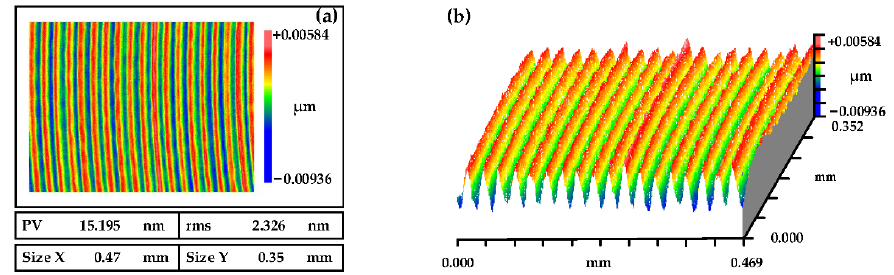
Figure 10. The roughness of the SPDT process. ( a ) Measurement Results, and ( b ) Three-dimensional a ) Measurement Results, and ( b ) Three- topography. (